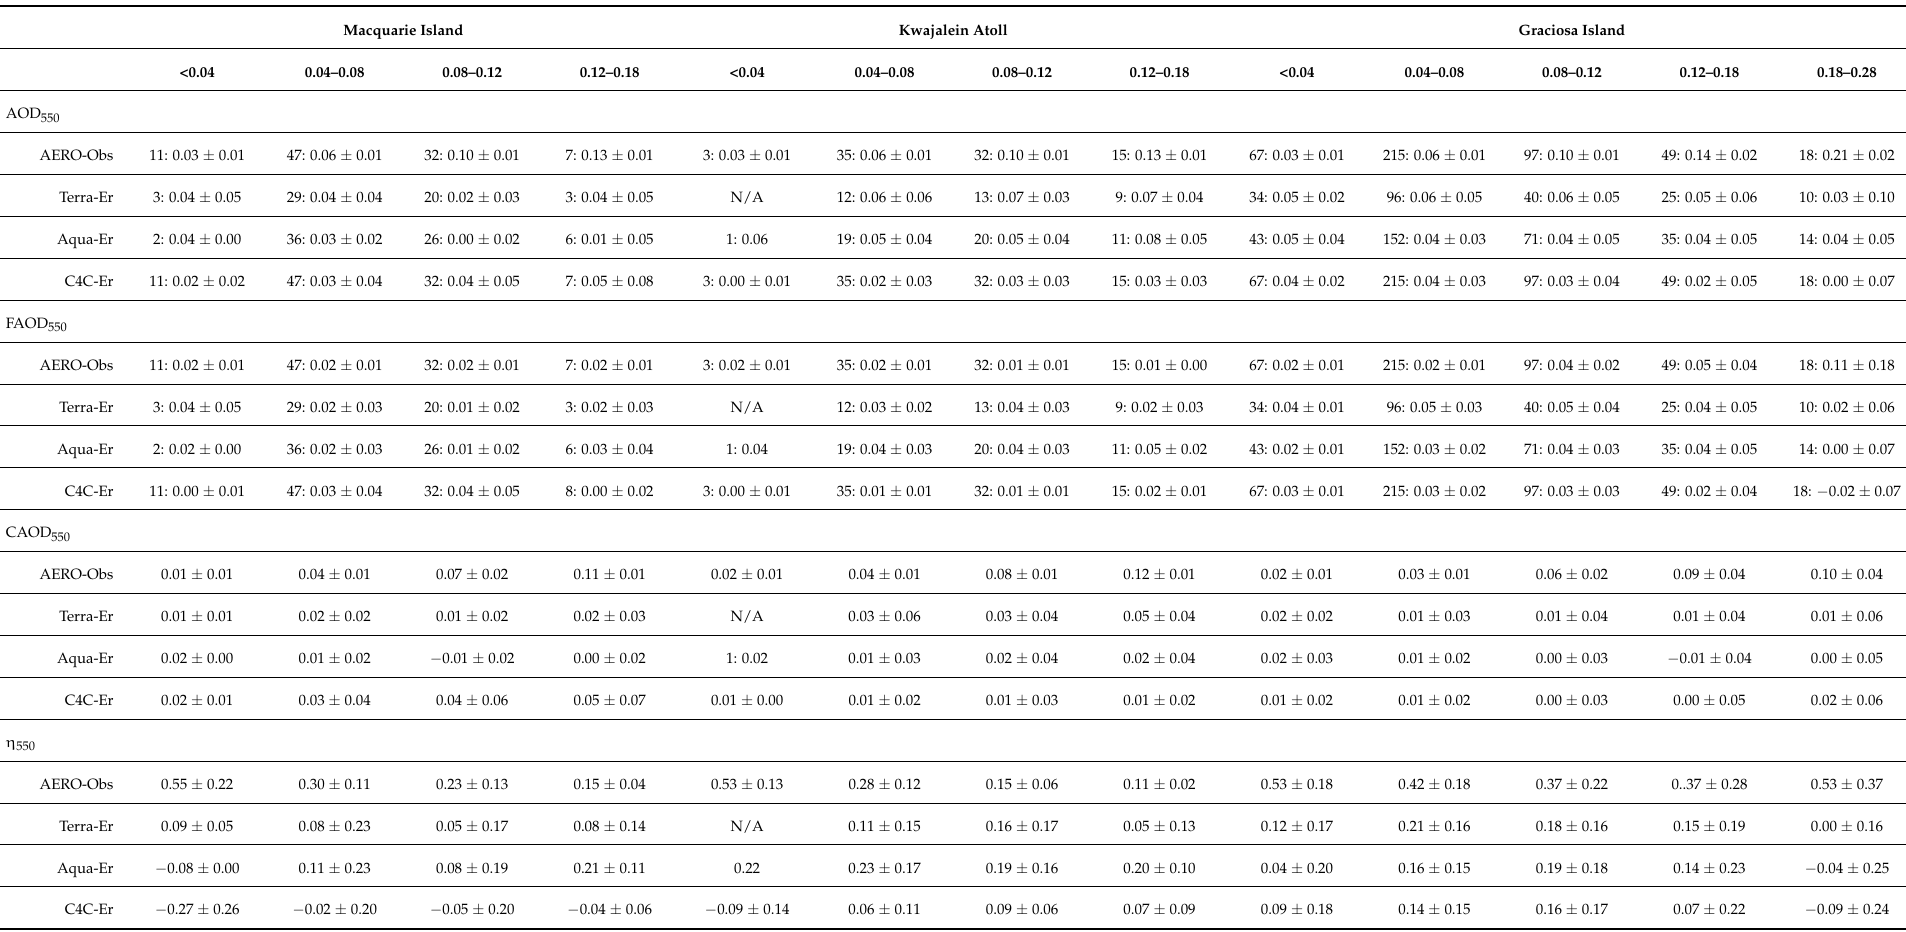
Table 8. Diagnostic error statistics for Terra and Aqua MODIS and the C4C consensus within Aerosol Optical Depth ranges (when available) for three AERONET sites of the remote ocean. Left columns: Macquarie Island in the southern oceans (54.5 ◦ S,158.9 ◦ E); middle columns: Kwajalein Atoll in central Pacific (8.8 ◦ N,167.7 ◦ E); right columns: Graciosa Island in the northern mid-latitude oceans (39.1 ◦ N, 28.0 ◦